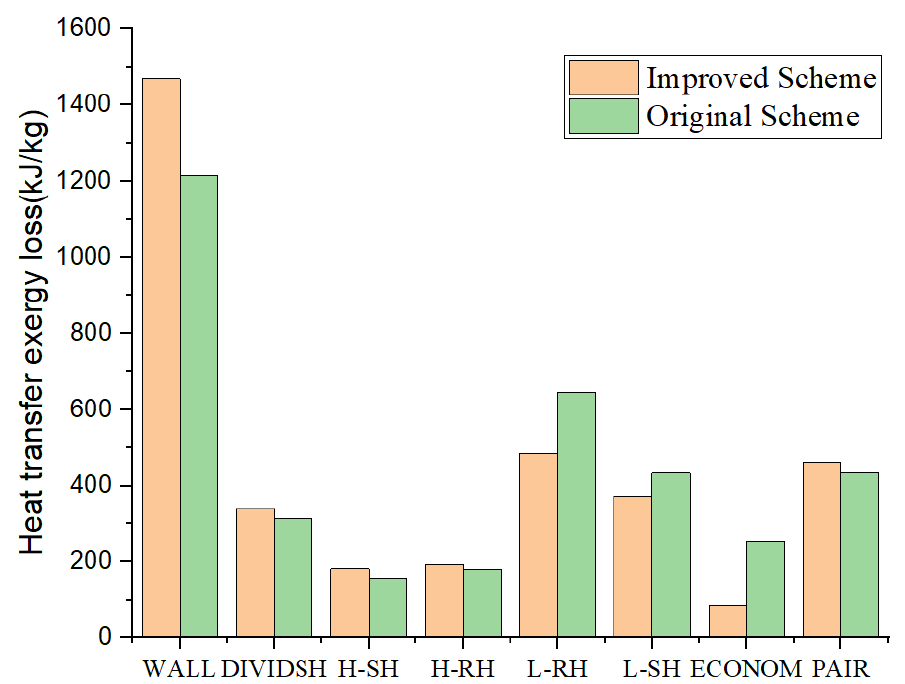
Figure 11. Comparison of heat transfer exergy loss distribution between the improved scheme and the original scheme.